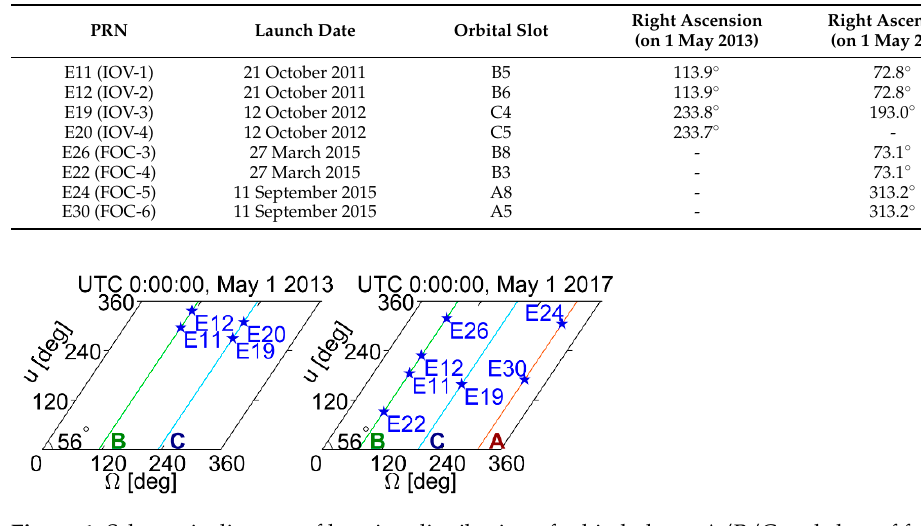
Figure 1. Schematic diagram of location distribution of orbital planes A/B/C and slots of four IOV and four FOC Galileo satellites at two epochs four years apart.